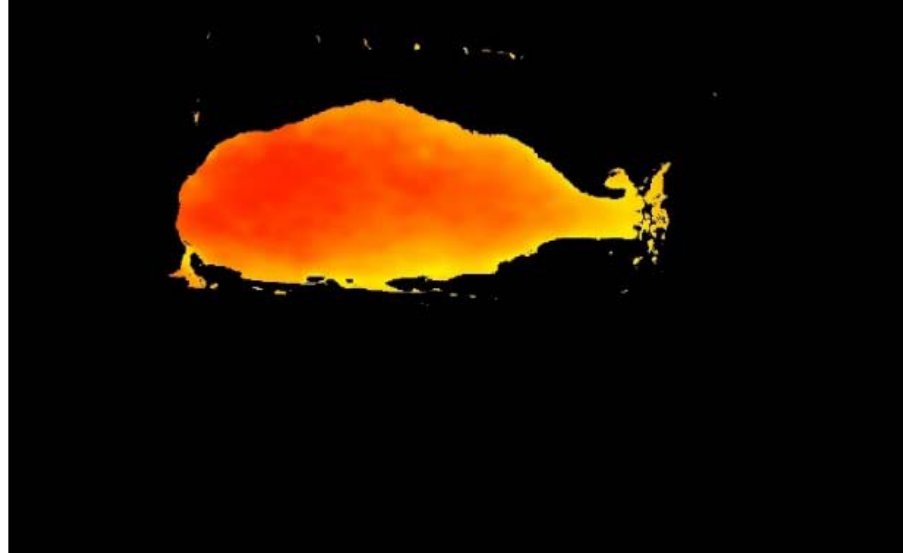
Figure 5. Final segmentation result of cattle in RGB ‐ D image.